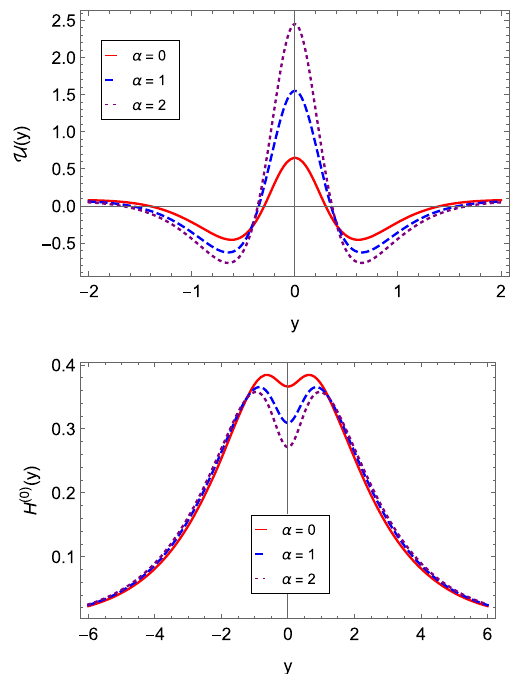
Fig. 10 Stability potential U ( y ) (top panel) and graviton zero-mode H ( 0 ) ( y ) (bottom panel) for the numerical solutions obtained in Sect. 2.3.1, with ϕ 0 = 10 = − ψ 0 , U 0 = k = φ 0 = 1, A 0 = 4 / 9, and A 1 = − 1 / 9, for different values of α